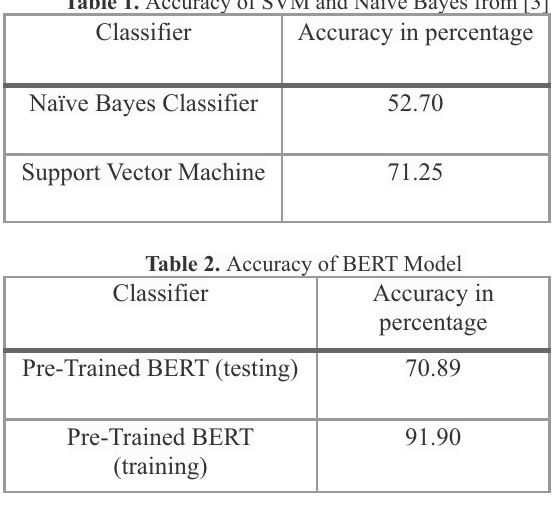
Table 2. Accuracy of BERT